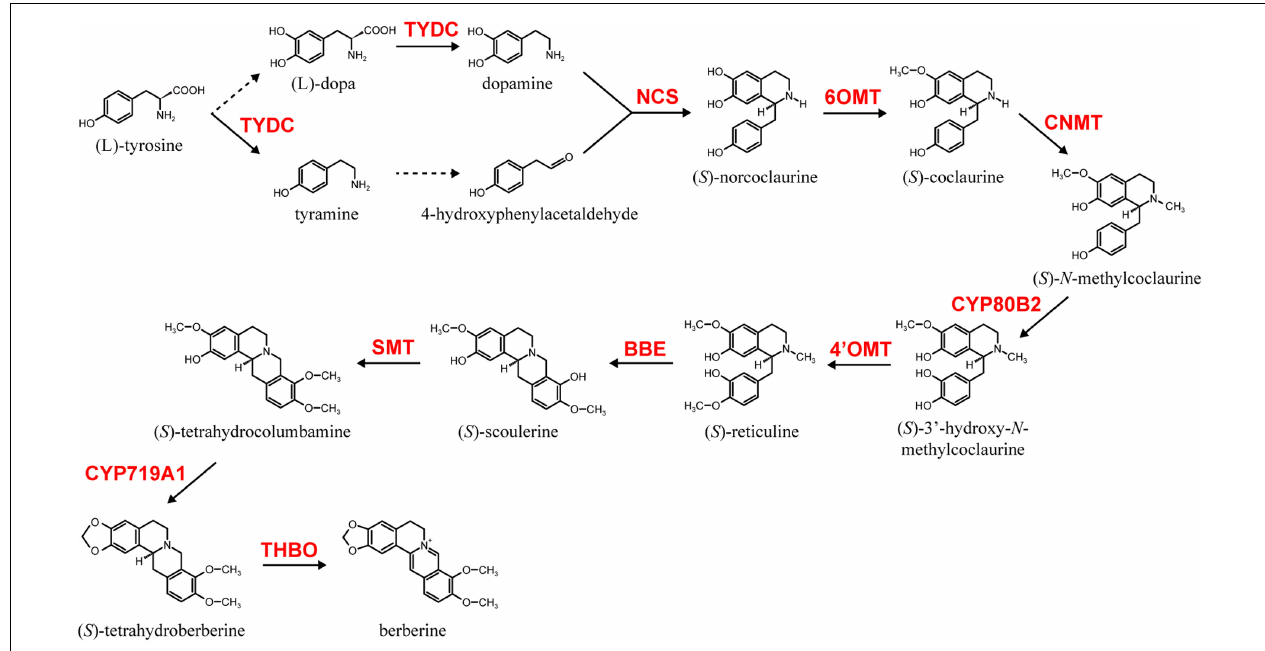
FIGURE 1 | The berberine biosynthetic pathway in Coptis japonica . Berberine biosynthetic enzymes abbreviations are noted as follows: NCS, ( S )-norcoclaurine synthase; 6OMT, ( S )-norcoclaurine 6- O -methyltransferase; CNMT, ( S )-coclaurine- N -methyltransferase; CYP80B2, ( S )- N -methylcoclaurine 3 (cid:48) -hydroxylase; 4 (cid:48) OMT, ( S )-3 (cid:48) -hydroxy- N -methylcoclaurine-4 (cid:48) - O -methyltransferase; BBE, berberine bridge enzyme; SMT, ( S )-scoulerine-9- O -methyltransferase; CYP719A1, ( S )-canadine synthase; THBO, ( S )-tetrahydroprotoberberine oxidase. Broken lines indicate uncharacterized enzyme reactions.